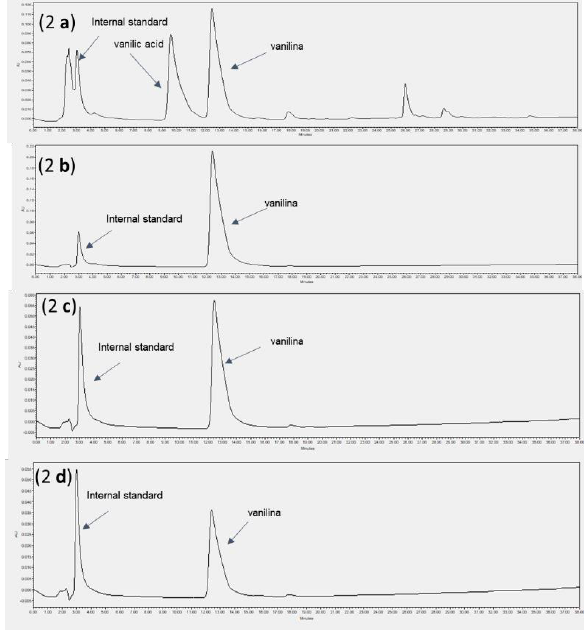
Figure 4. Vacuum distillation experiments: HPLC chromatograms obtained at the end of Experiment 5 (Chromatograms 1) and at the end of Experiment 6 (Chromatograms 2). For each experiment, different samples were analysed: ( ia ) final feed; ( ib ) 1st condenser; ( ic ) 2nd condenser; and ( id ) 3rd condenser, where i is the number of the chromatogram.